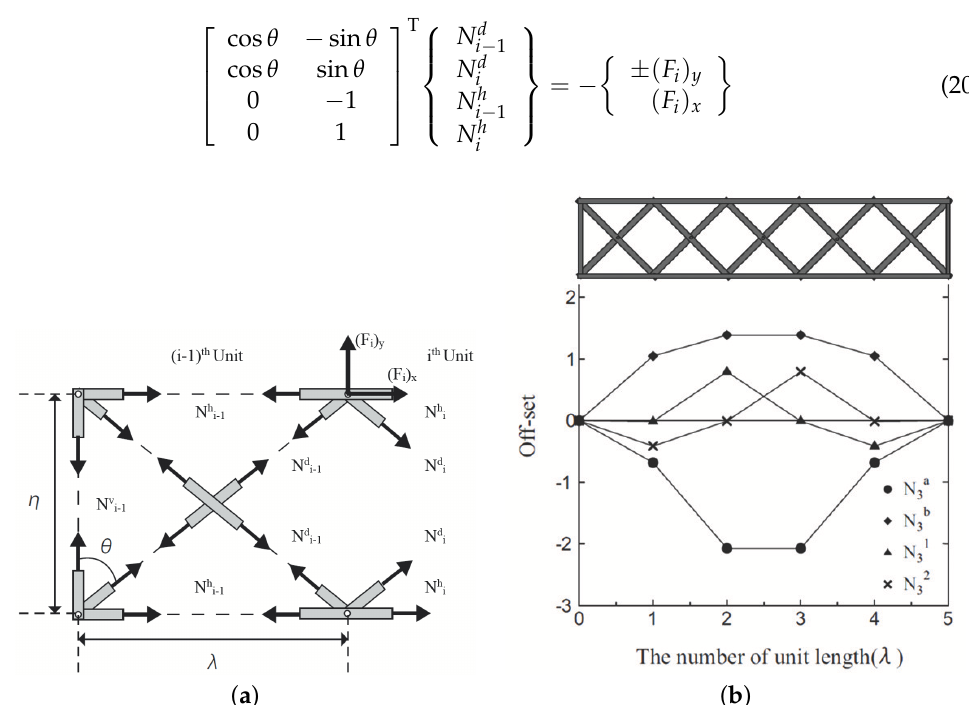
Figure 8. The sectional nodal forces and I.L. of axial force at 3rd unit of DWT. ( a ) The sectional nodal forces. ( b ) I.L. of axial force at 3rd unit of